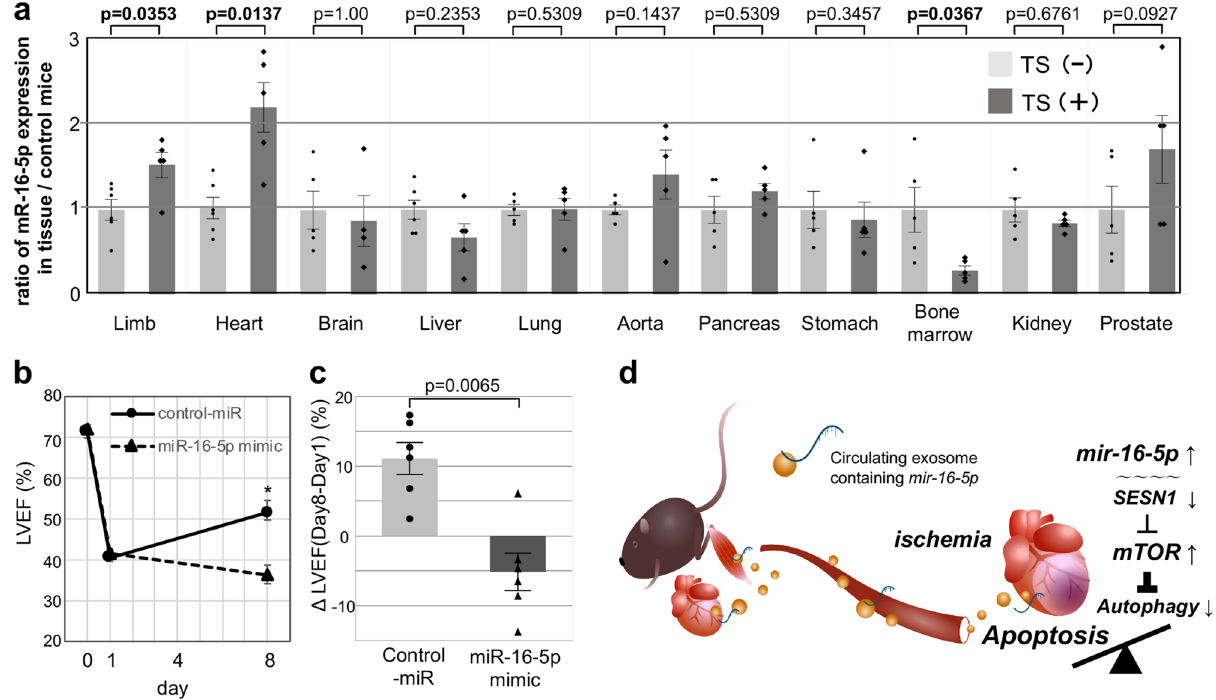
Figure 6. Circulating miR-16-5p is derived from the atrophic-limbs and hearts of sarcopenic mice and interferes with restoration of LV dysfunction in I/R mice. a, qRT-PCR analysis of the expression of miR-16-5p in the brain, liver, limbs, heart, lung, aorta, pancreas, stomach, bone marrow, kidney, and prostate of mice subjected [TS (+)] or not [TS (−)] tail-suspension (all; n = 5). The ratio of miR-16-5p expression in TS (+) mice was calculated compared that in TS (−) mice (standardized to the expression level of 1). Light gray bar; TS (−), Dark gray bar; TS (+). ( b ) Absolute changes in the LVEF on days 8 in miR-16-5p mimic (n = 6) and control- miR mimic (n = 6), *p < 0.05. ( c ) ΔLVEF (Day 8–Day 1) in the 2 groups of mice. Left bar; control-miR mimic, Right bar; miR-16-5p mimic. ( d ) Schematic image of the proposed mechanism. Cardio-repair disturbance in induces cell